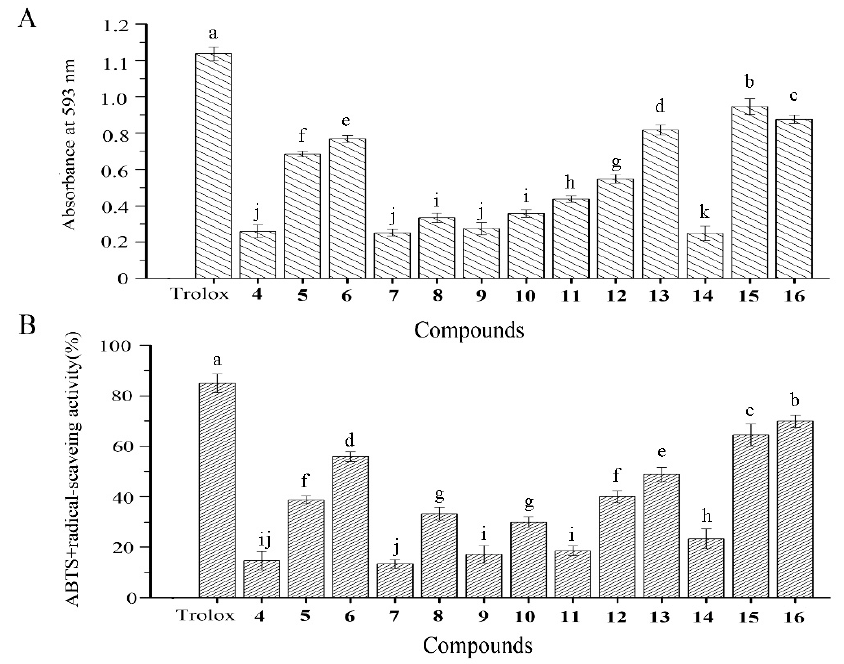
Figure 4. ( A ) FRAP activity and ( B ) ABTS + radical-scavenging activity of the isolated compounds. Amicoumacin D, 4 , E, 5 , N-butanonyl-amicoumacin C, 6 , amicoumacin A–C, 7 – 9 , bacilosarcin A–C, 10 – 12 , N -acetylamicoumacin B–C, 13 – 14 , AI-77-H, 15 , lipoamicoumacins B, 16 . Results labeled with different lowercase letters (a–k) within each column indicate significant differences ( p < 0.05).